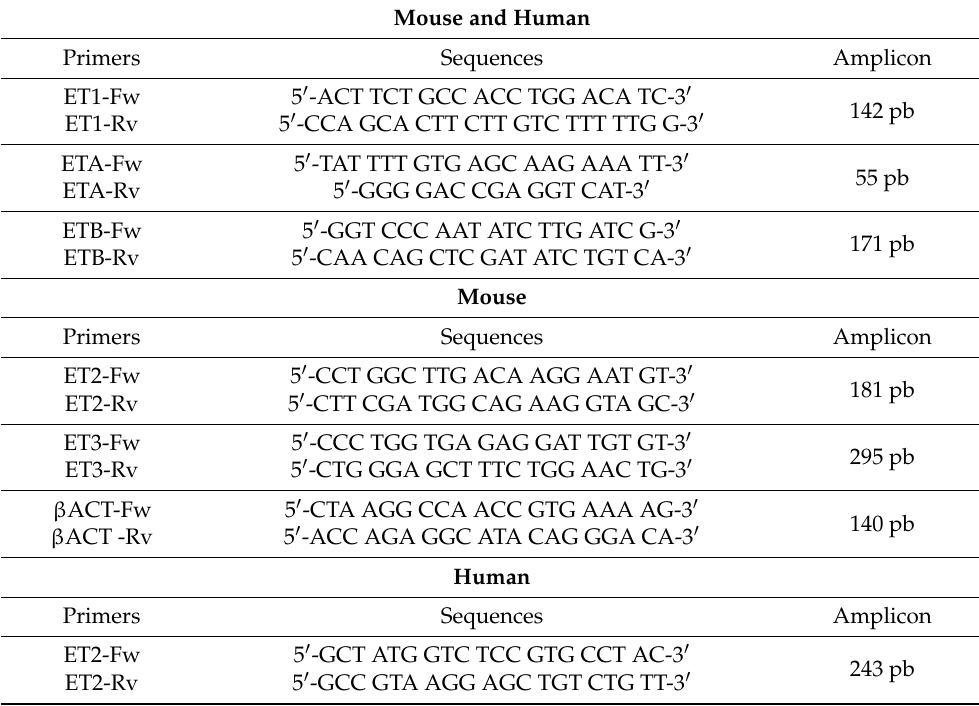
Table 1. Primers used for RT-qPCR.